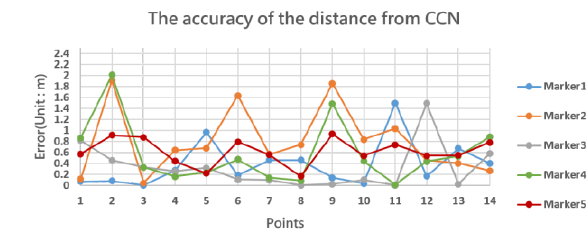
Figure11. The accuracy of the distance from